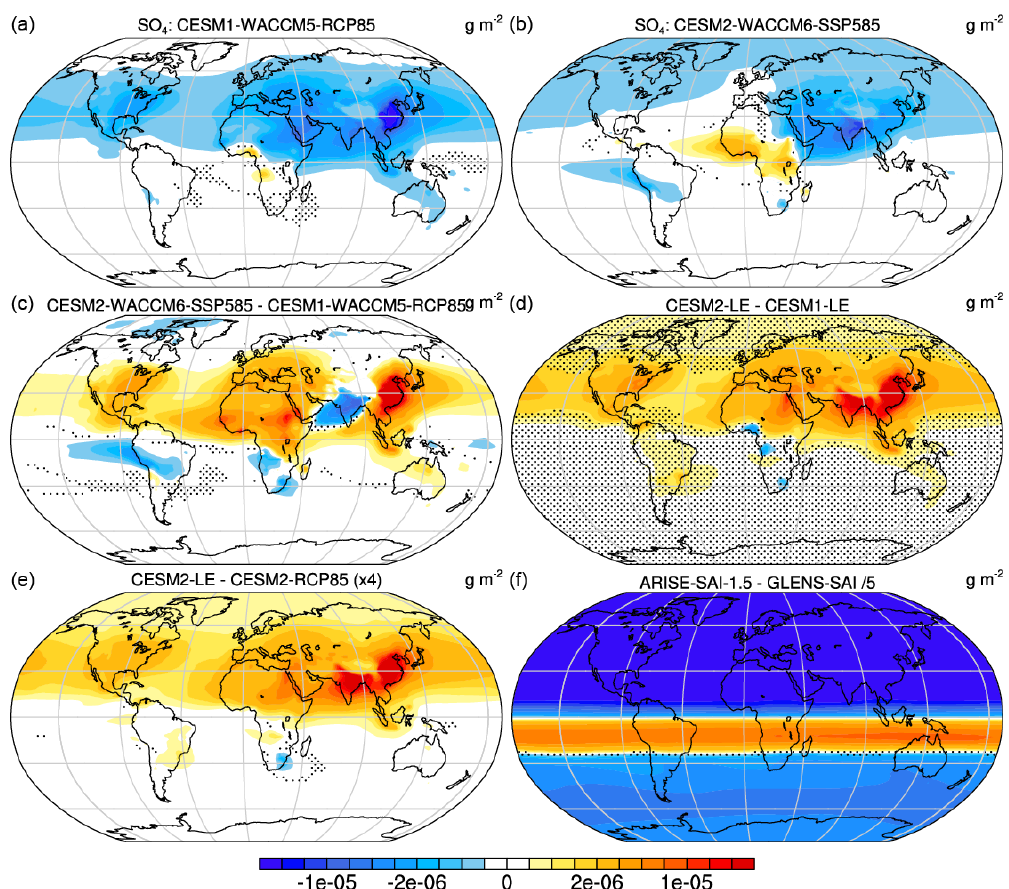
Figure 7. Absolute change in sulfate aerosol burdens (SO 4 ) estimated from the difference between 2020–2039 and 2050–2069 for unmit- igated (a) CESM1-WACCM5-RCP85 and (b) CESM2-WACCM6-SSP585 simulations, and (c) their difference ( a minus b ). Also shown is (d) the analogous difference for CESM1-LE and CESM2-LE and (e) CESM2-RCP85 and CESM2-LE. The difference between the geoengi- neered climate states in ARISE-SAI-1.5 and GLENS-SAI is shown in panel (f) . Units for all panels are gm − 2 and stippled regions indicate differences that are less than twice the ensemble standard error. The difference field in panel (f) is scaled by 1 /